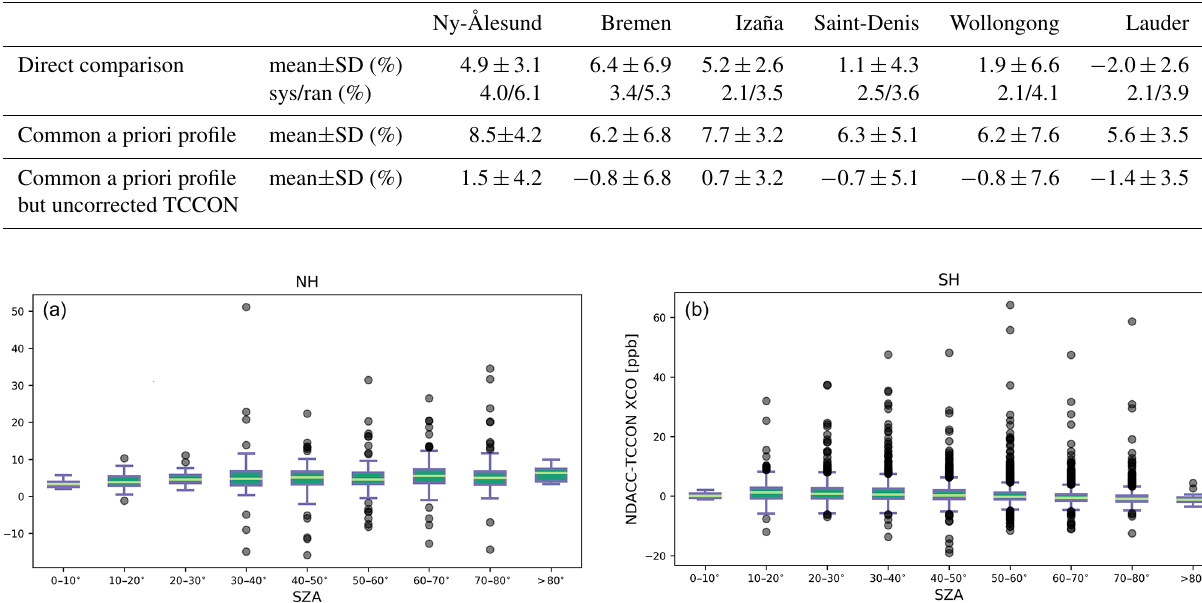
Figure 2. The box plot of the differences between the TCCON and NDACC X CO measurements as a function of SZA for Northern Hemi- sphere (a) and Southern Hemisphere sites (b) . The bottom and upper boundaries of the box represent the 25th and 75th percentiles of the data points around their median value (green line), and the error bars indicate the 5th and 95th percentiles of the data